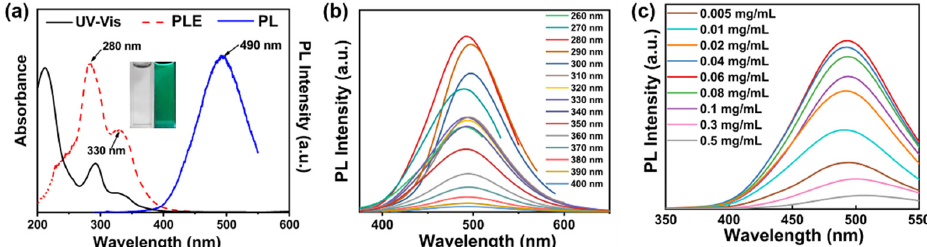
Figure 3. The optical properties of NFCDs solution at 0.02 mg/mL: ( a ) UV-vis absorption at 210 nm, 280 nm and 330 nm, and excitation peaks at 280 nm and 330 nm (PLE), together with 490 nm emission PL spectra (inset: left—NFCDs solution under daylight; right—NFCDs solution under UV light). ( b ) The emission spectra at 490 nm for NFCDs solution with different excitation wavelengths. ( c ) The emission spectra of NFCDs with concentrations ranging from 0.005 to 0.5 mg/mL.